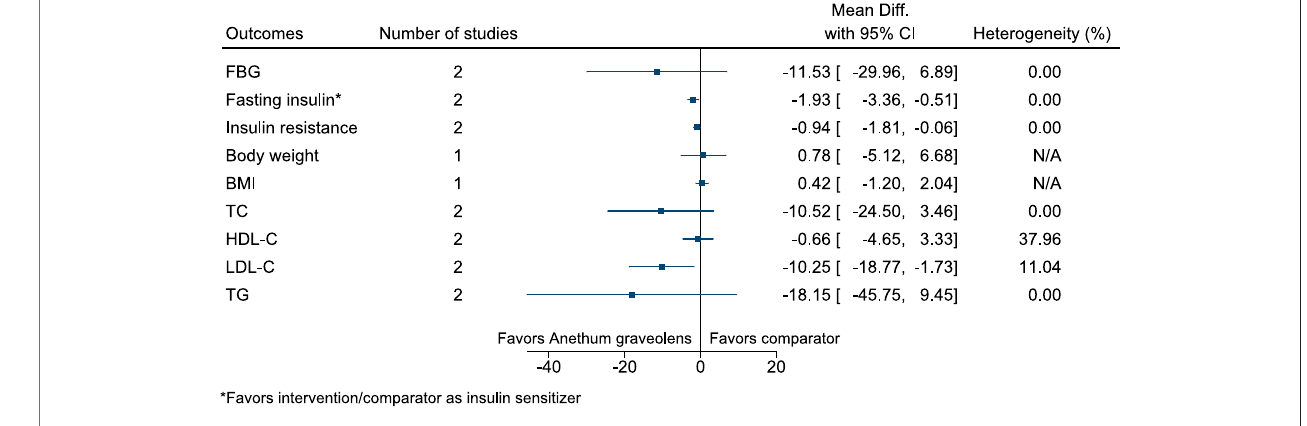
FIGURE 5 | Anethum graveolens — Summary forest plot.